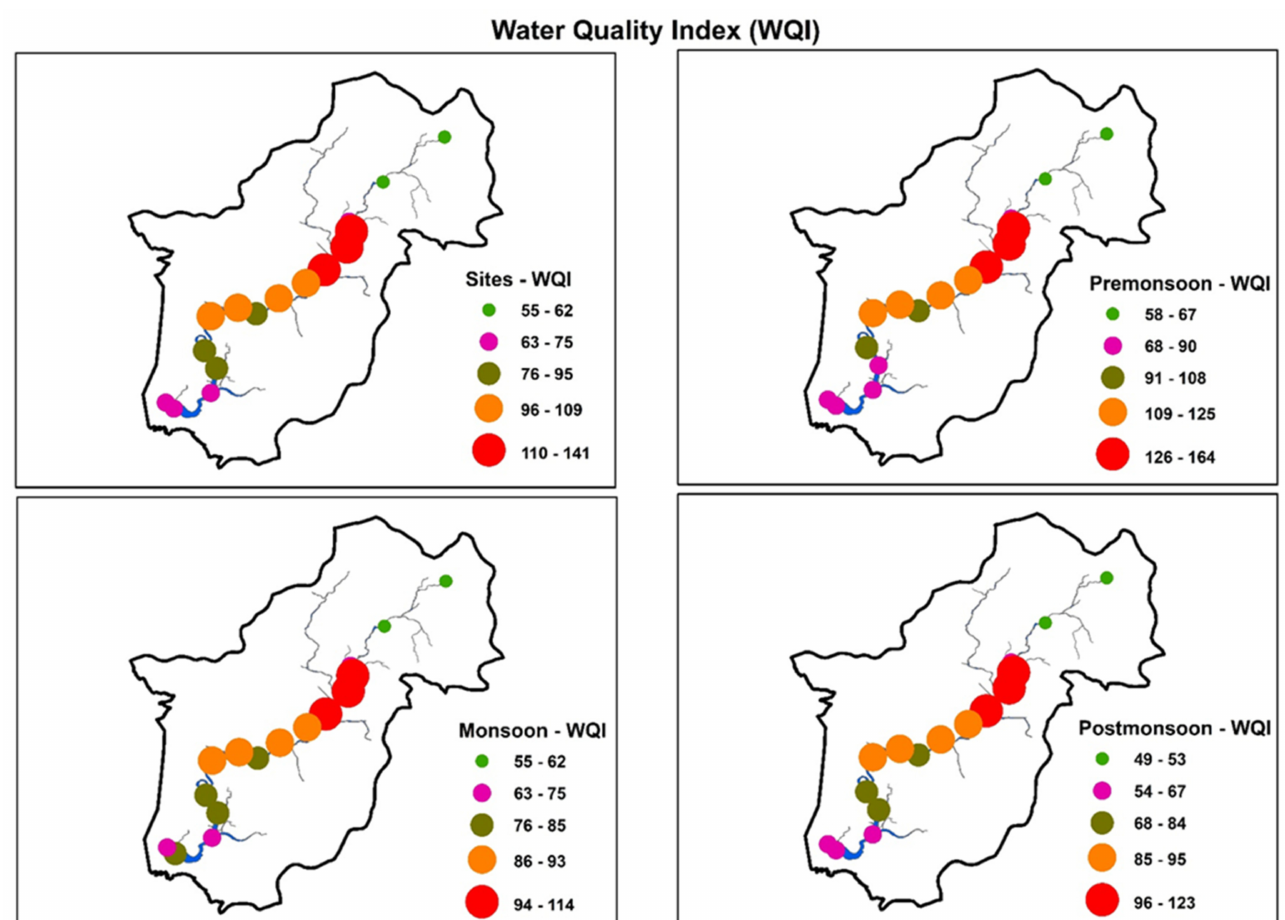
Figure 5. Water quality status at spatial and temporal scales in the river (premonsoon: January–June; monsoon: July–August; postmonsoon: September–December). For site identification, please refer to Figure